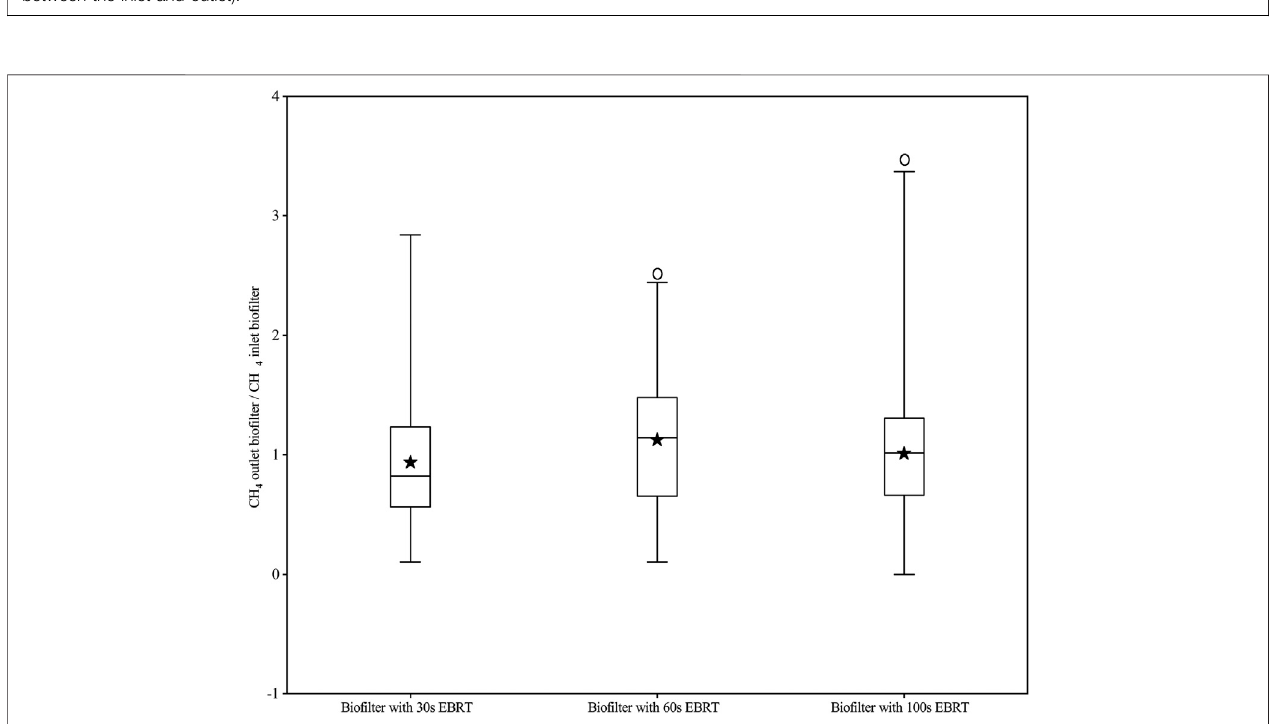
FIGURE 4 | Boxplot: Ratio of CH4 concentrations of the outlet and inlet at different bio fi lters (Box border means 25 and 75% percentile, the solid line in the box means the median value, a solid pentacle means the mean value, a whisker means the maximum and the minimum values, and the white circle means signi fi cant differences between the inlet and